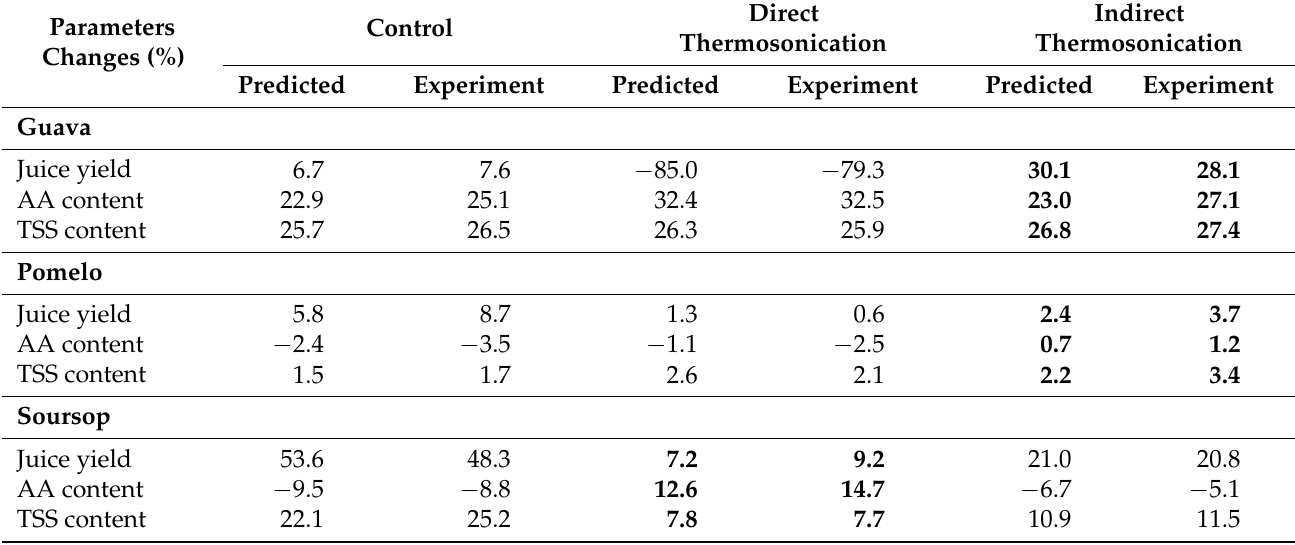
Table 5. Predicted and experimental optimal responses of guava, pomelo, and soursop extraction.